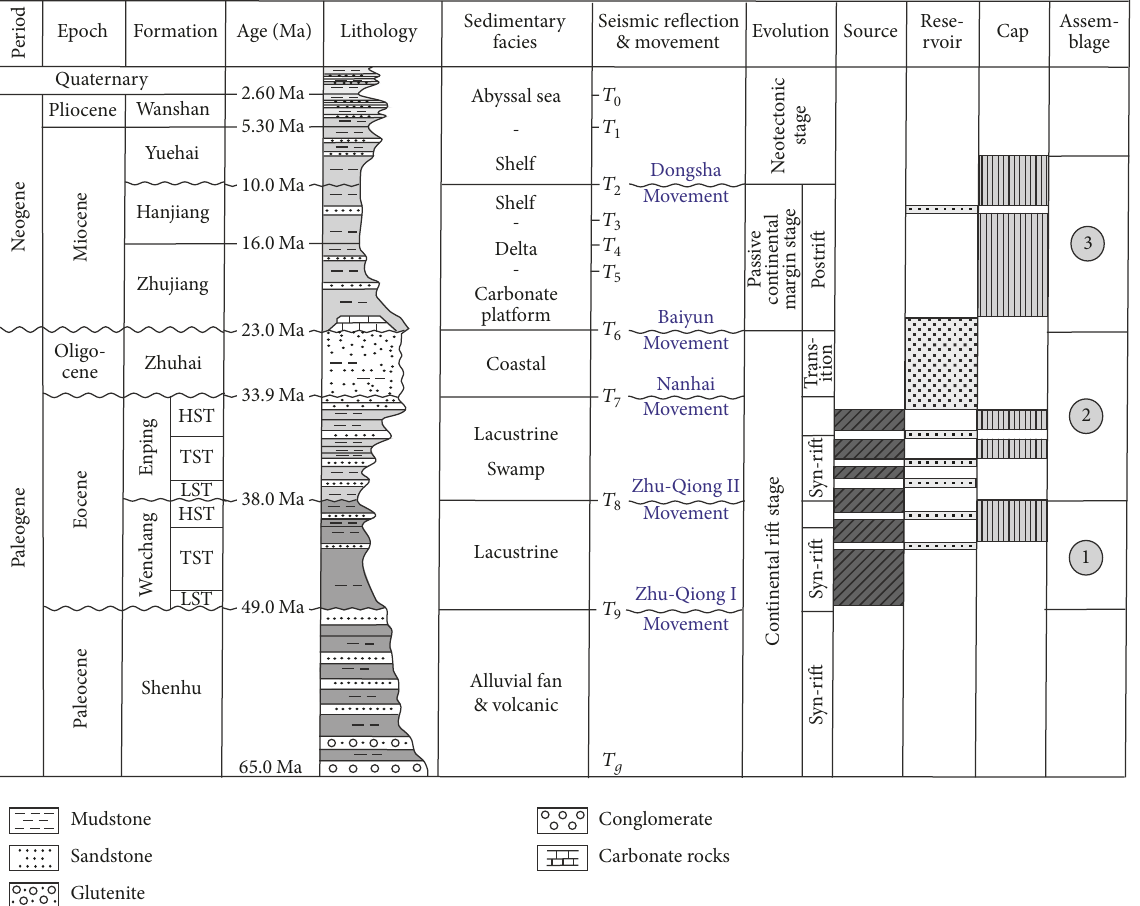
Figure 2: Simplified lithostratigraphy and source-reservoir-cap assemblage of the Huizhou Sag. See Figure 1 for the location of the Huizhou Sag (lithostratigraphic sequence modified from [37]). (LST: lowstand systems tract; TST: transgression systems tract; HTS: highstand systems